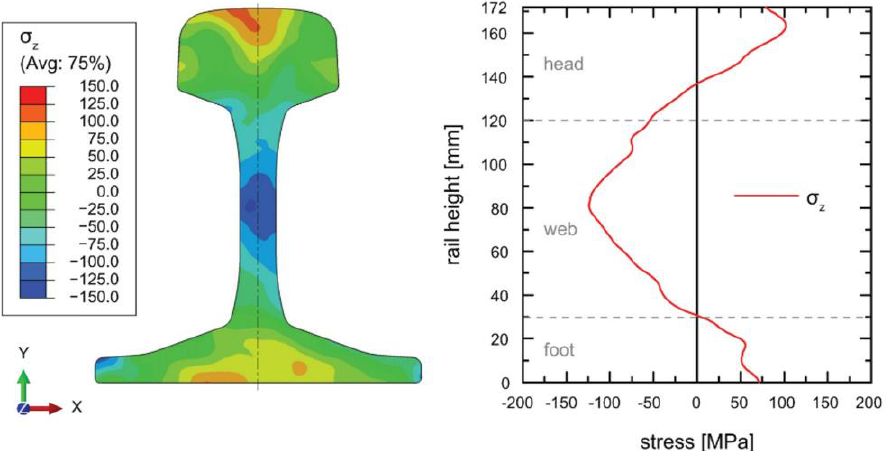
Figure 6. A study by Kaiser et al. [56] showing a 2D stress map and profile of a rail cross section obtained using the contour method.